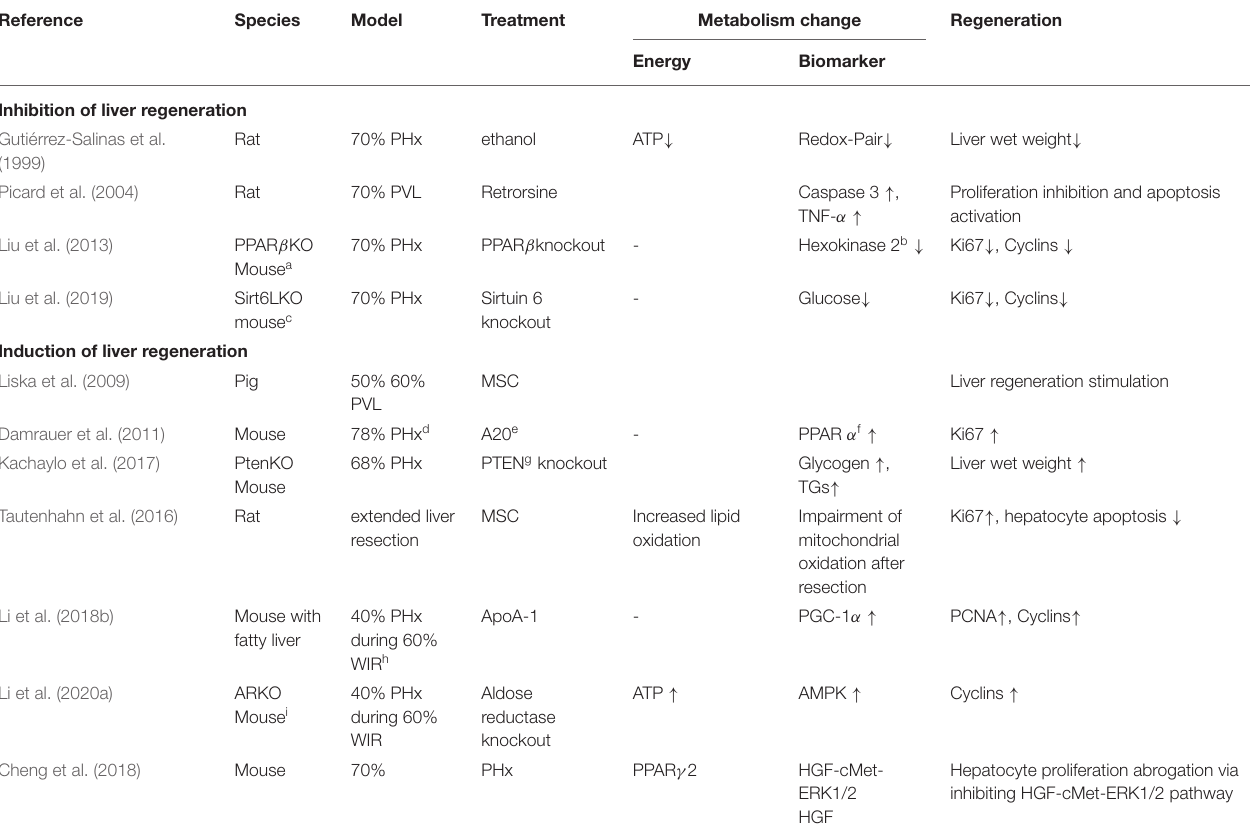
TABLE 4 | Interaction between resection–regeneration and metabolism. Reference Species Model Treatment Metabolism